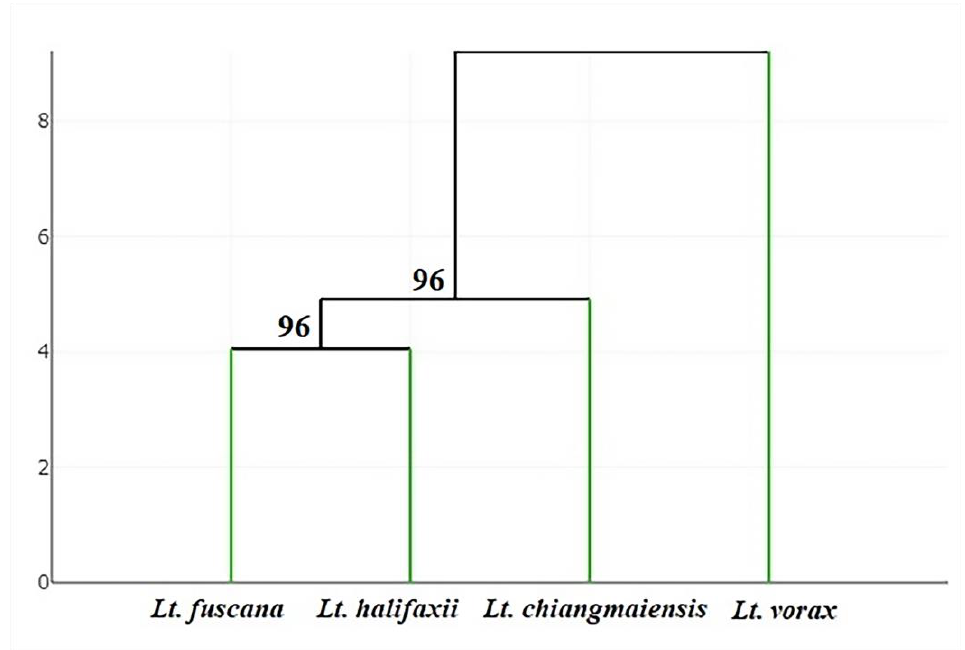
Figure 7. Hierarchical clustering tree based on the Mahalanobis distances between average group shapes showing wing shape similarity among Lutzia species. The percentages of bootstrap values based on 1000 replicates are shown above the branches. Table 3. Identification error and percentage of correct classification based on the wing shape of Lt. chiangmaiensis , Lt. fuscana , Lt. halifaxii , and Lt. vorax calculated by a cross-validated reclassification